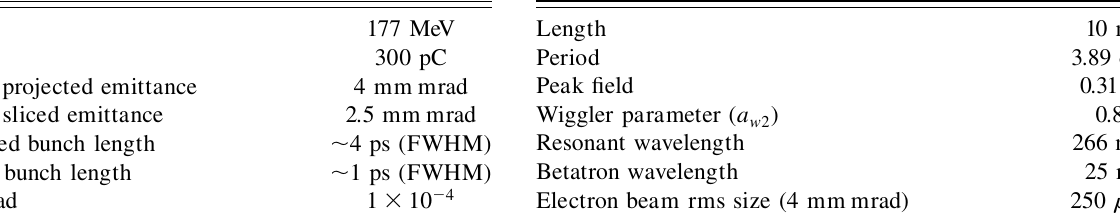
Electron beam parameters.